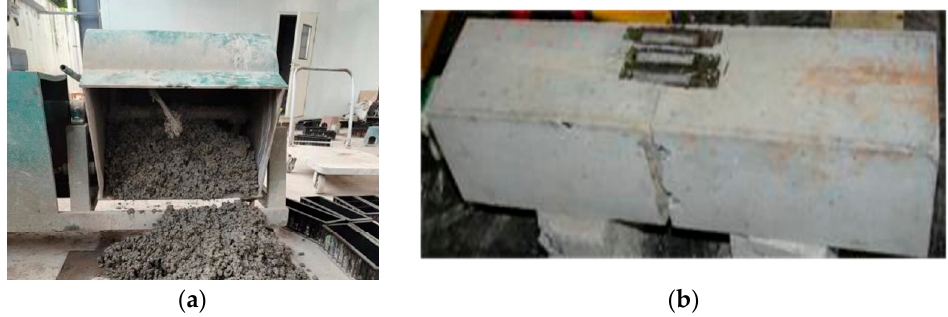
Figure 3. Mixed concrete ( a ) and processed SFHSC specimen ( b ).